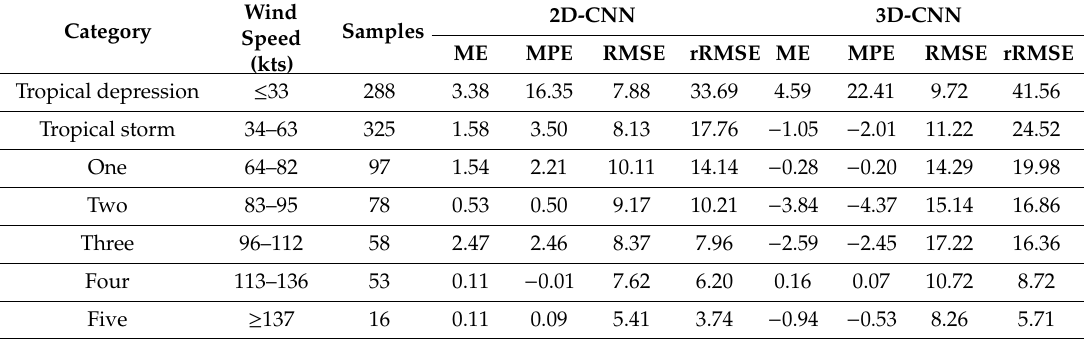
Figure 7. Validation results of the tropical cyclone intensity estimation based on the selected 2D- / 3D-CNN models. Table 5. Validation results according to Sa ffi r–Simpson typhoon scale (Index (unit): ME (kts), MPE (%), RMSE (kts) and rRMSE